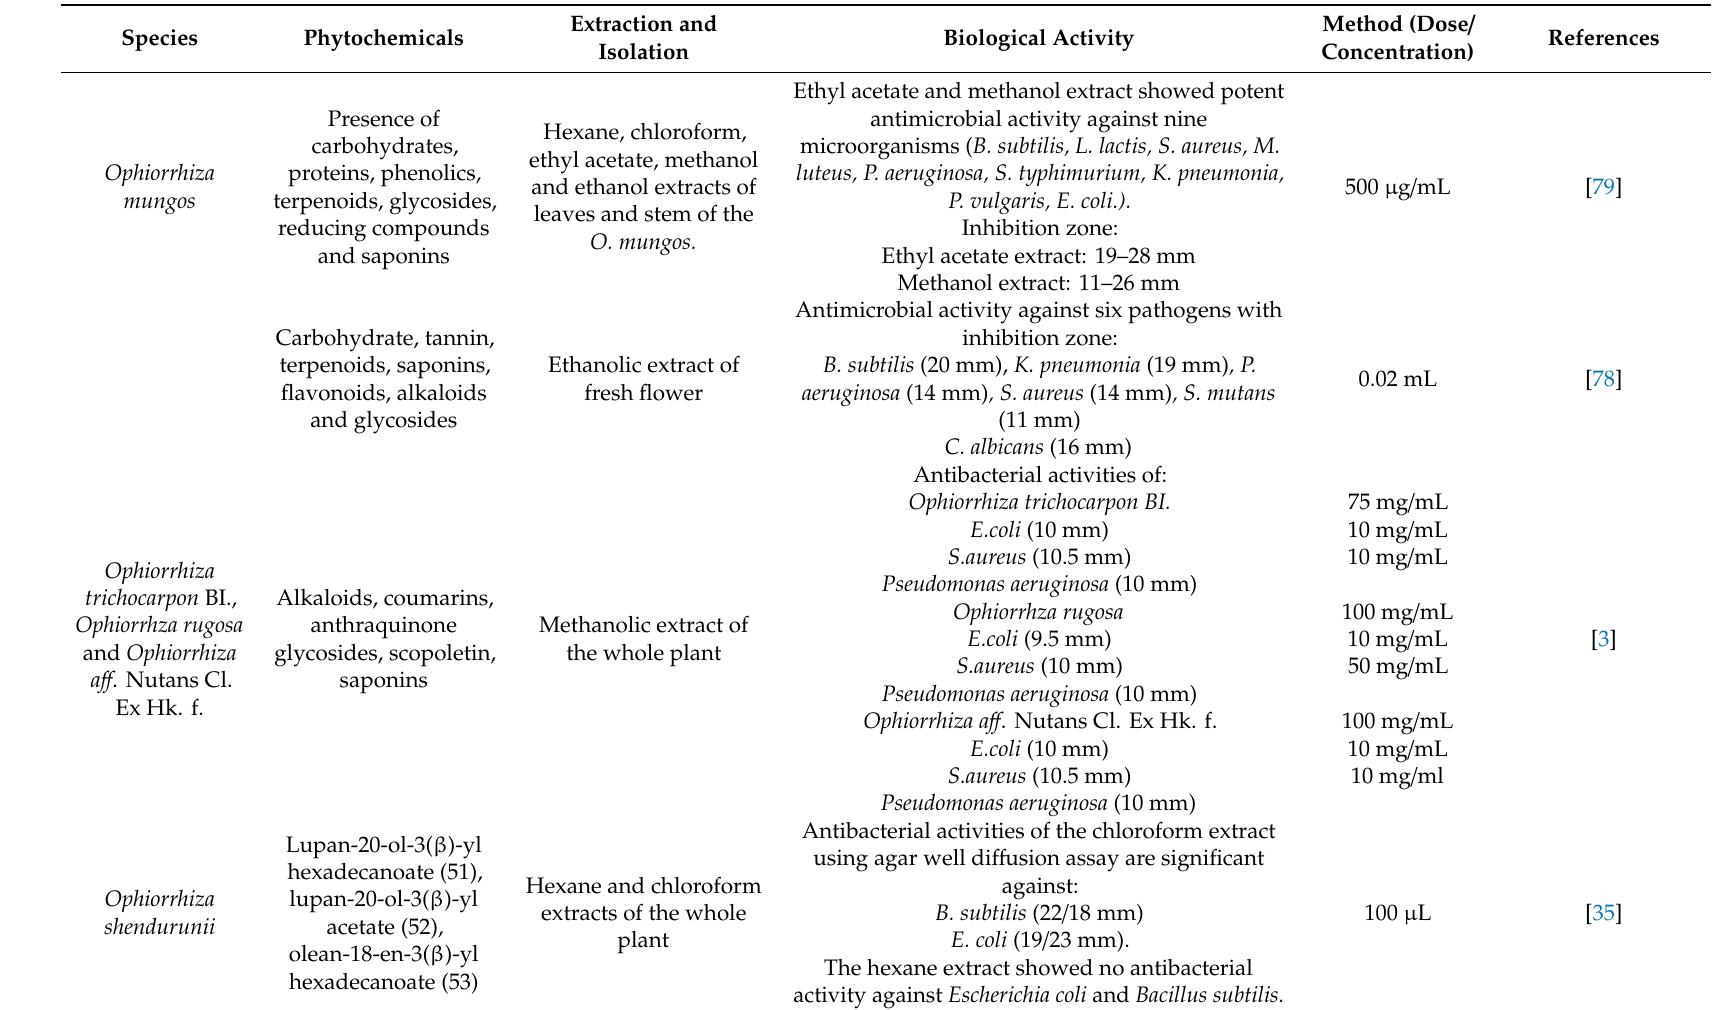
Table 8. Antimicrobial